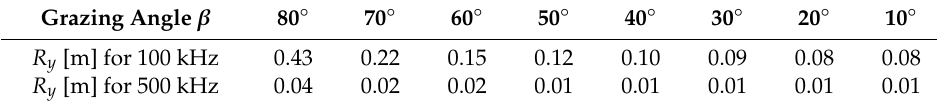
Table 2. Calculated across-track resolution of the DF-1000 EdgeTech side-scan sonar. Grazing Angle β